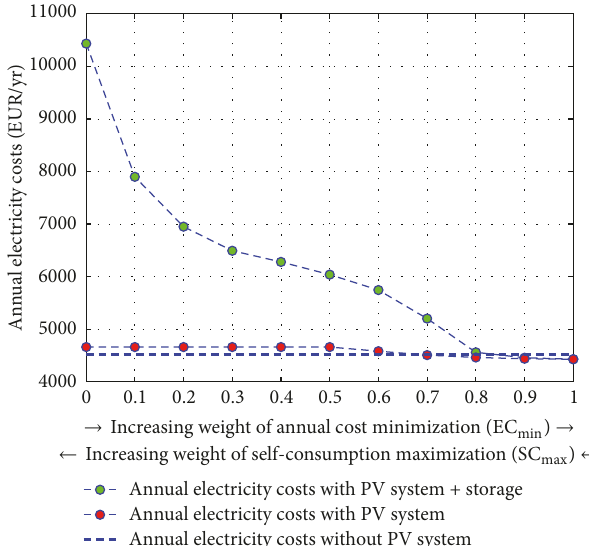
Figure 14: Austrian retail electricity prices: comparison of annual electricity costs.